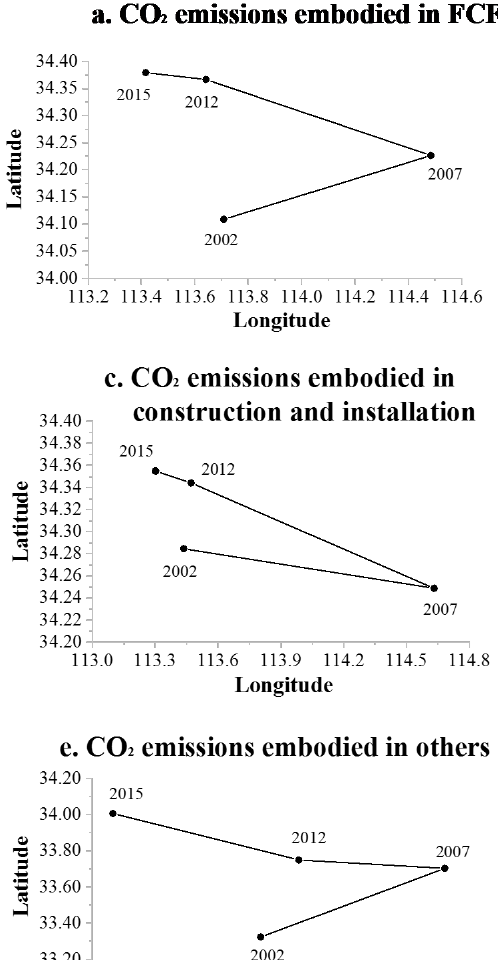
2 emissions embodied in